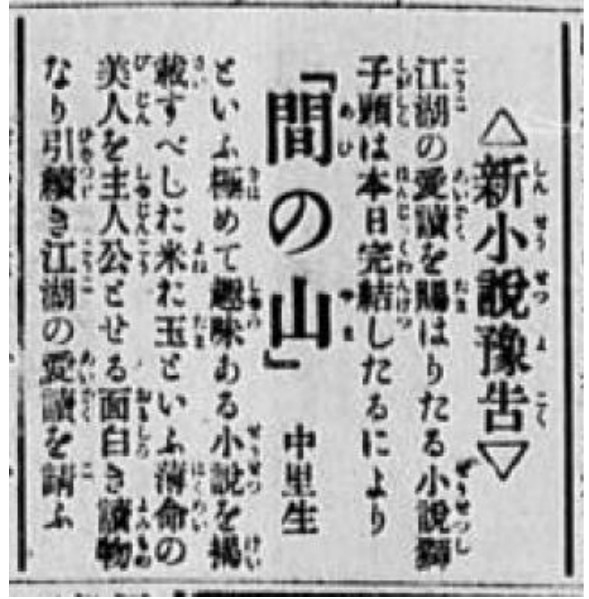
Figure 2. Advertisement for “Ai no Yama”. Nichibei shinbun 26 January 1918. Image courtesy of the Hoji Shinbun Digital Collection.